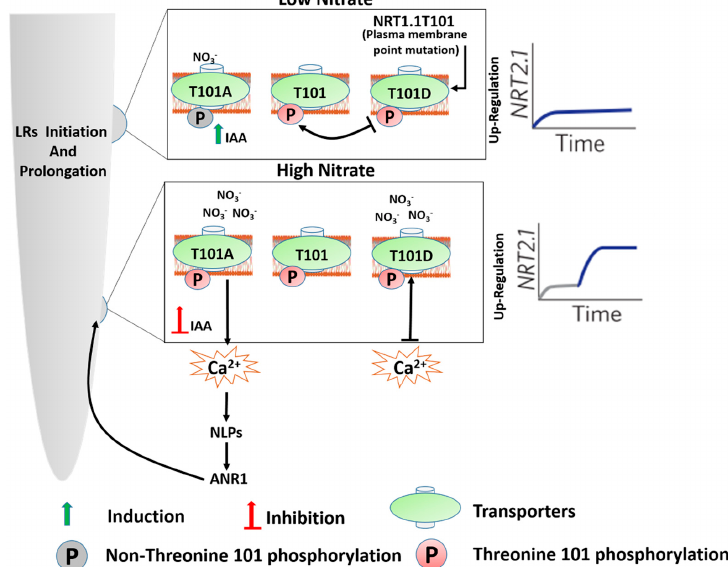
Figure 2. The schematic diagram describes the differential phosphorylation status of NRT1.1.1T101 at plasma membrane (PM) in the Arabidopsis root, modified by [52]. The layout represents the two binding sites’ low affinity (LA) and high affinity (HA) of T101A . The T101A mutant at the LA binding site follows the NRT1.1-ANR1 signaling pathway upon prolonged exposure to the NO 3 − under low-nitrate conditions, resulting in LR elongation. This is a nonphosphorylated form of NRT1.1-induced signaling that promotes LRs. In the inserted graph, the grey line represents the weak upregulation of NRT2.1 under low nitrate, and the blue line represents the strong upregulation of NRT2.1 under high nitrate. The graphs on the left and right represent the NRT2.1 induction; see text for more details.